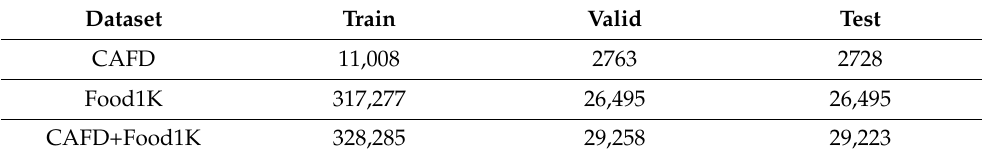
Table 2. Image distribution across the training (train), validation (valid), and test sets.